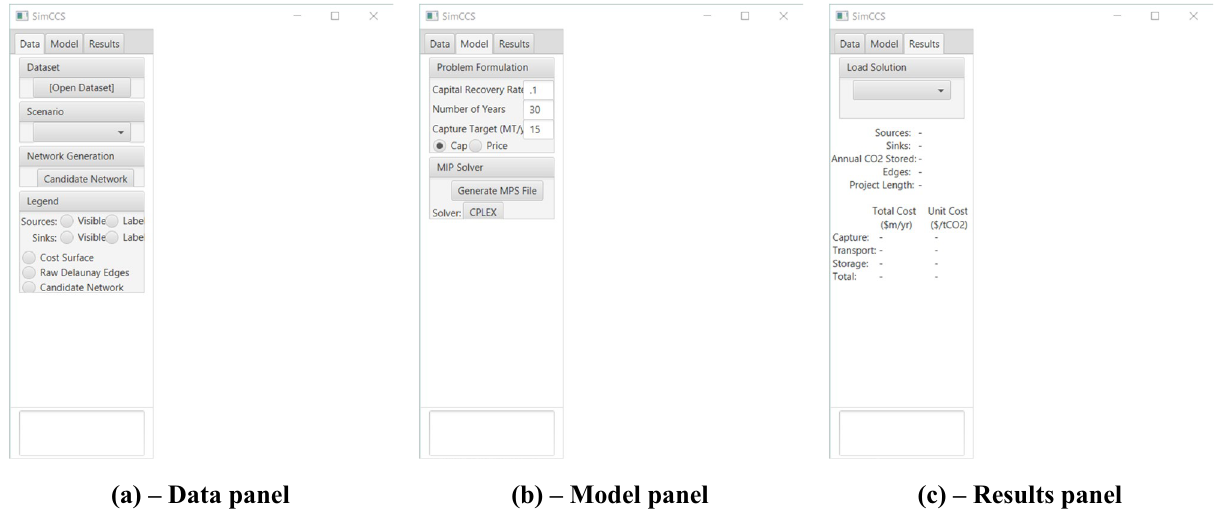
Figure 1. Different panels in SimCCS 2.0